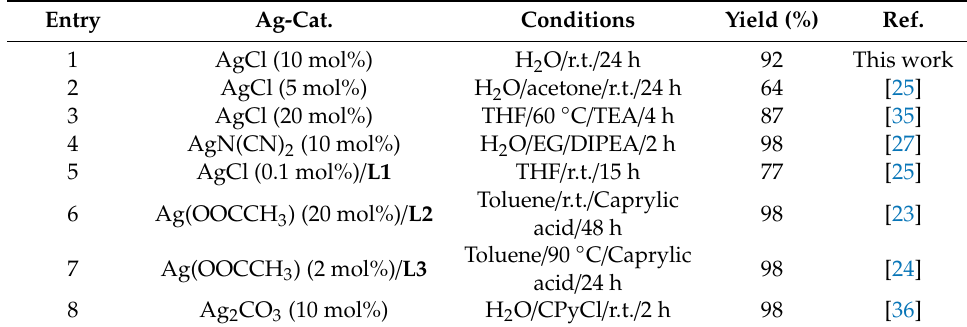
Table 1. Comparative study of AgAAC reactions of phenylacetylene ( 1a ) and benzyl azide ( 2a ) under di ff erent reaction conditions.